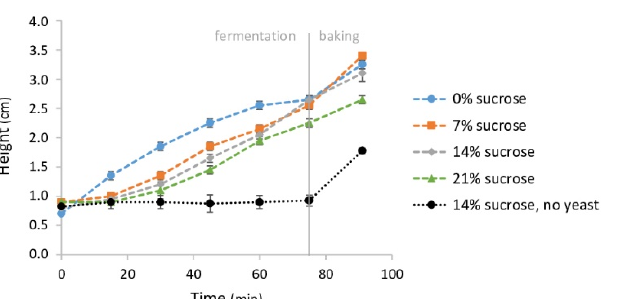
Figure 6. Height (cm) of pastry samples with 8% yeast and 0, 7, 14 and 21% sucrose and samples with 0% yeast and 14% sucrose as a function of time (min) during pastry production. The start of fermentation is defined as t = 0. Samples were fermented at 30 °C and 80% relative humidity for 75 min and baked at 220 °C for 16 min. Vertical bars represent standard deviations of duplicate measurements.